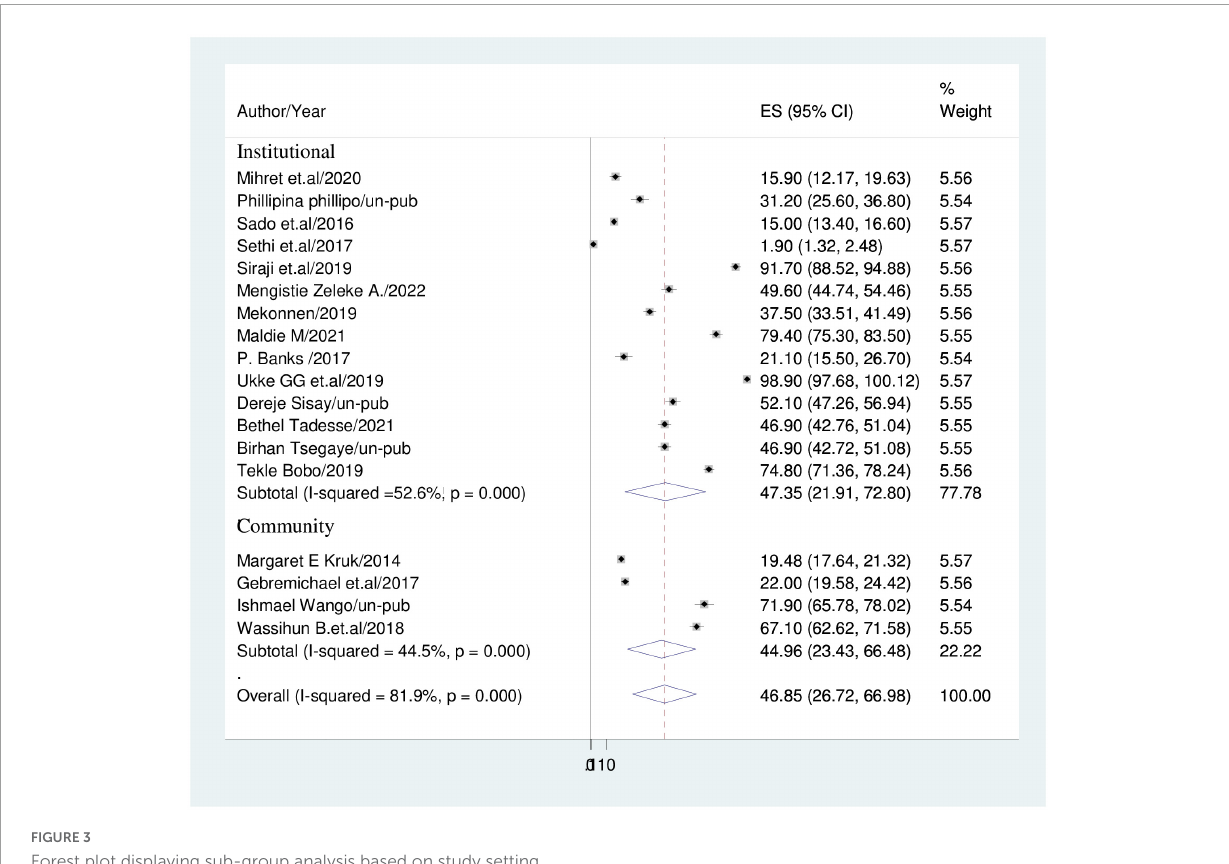
studies carried out at healthcare facilities. Thirteen studies were carried out in Ethiopia (41, 43–48, 50–56), three in Tanzania (26, 28, 42), one in Kenya (49), and one in Sudan (51). Sample sizes varied from 204 to 2109. Disrespect and abuse of women during childbirth varied in prevalence from 1.9 to 98.9% ( Table 1